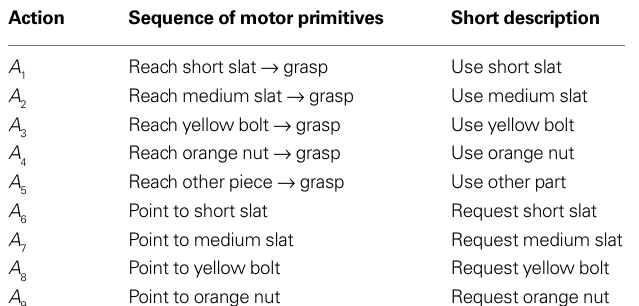
Table 1 | Goal-directed sequences and communicative gestures in ASL. Action